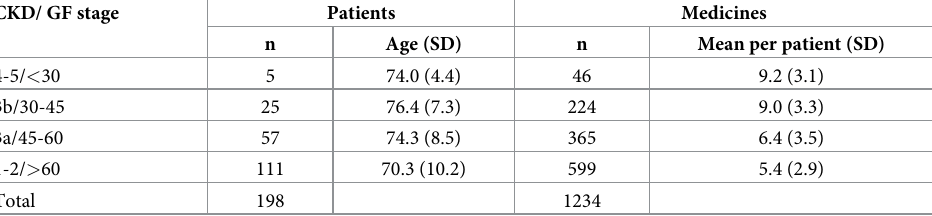
Table 3. Patients and medications grouped according to CKD